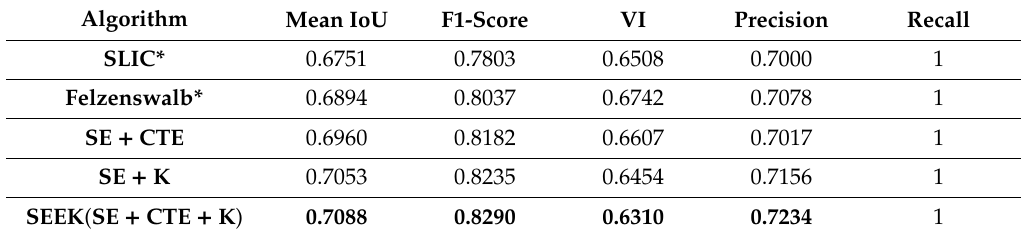
Table 1. The improvement in mean IoU for di ff erent